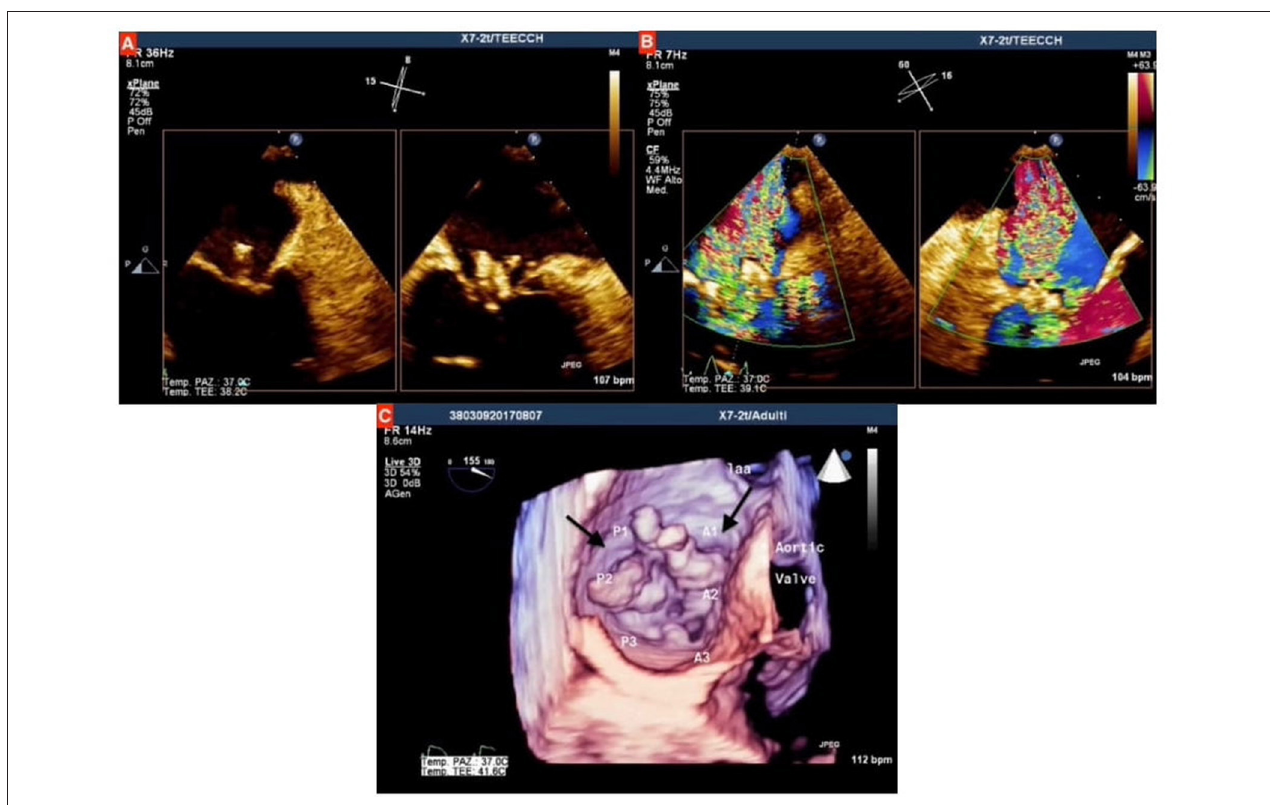
FIGURE 1 | (A) Qualitative assessment of mitral valve at transesophageal echocardiogram (TEE), showing the two vegetations on both anterior and posterior mitral valve leaflets, which protrude toward left atrium during systole; (B) Assessment with color doppler showing severe mitral regurgitation; (C) three-dimensional assessment at TEE, the black arrows indicate the two vegetations on mitral leaflets.